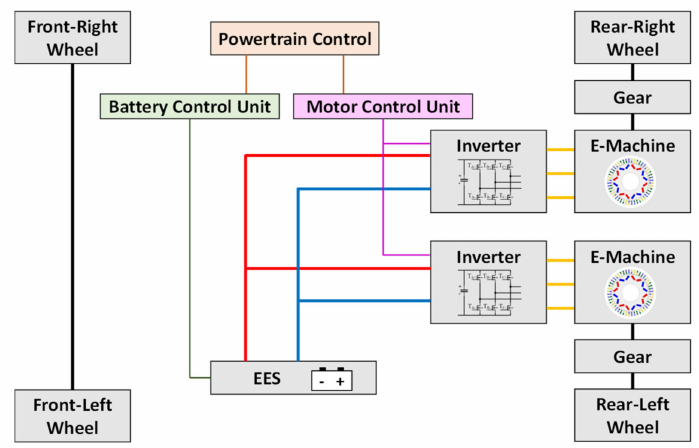
Figure 1. Distributed rear-drive full-electric